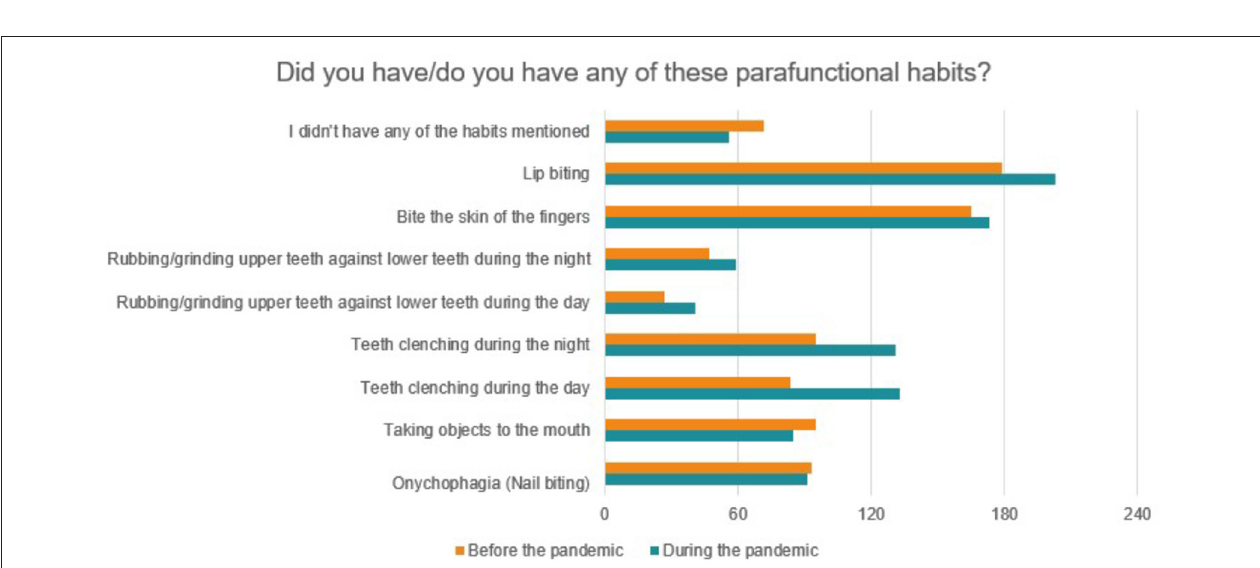
FIGURE 10 | Parafunctional habits observed before and during the